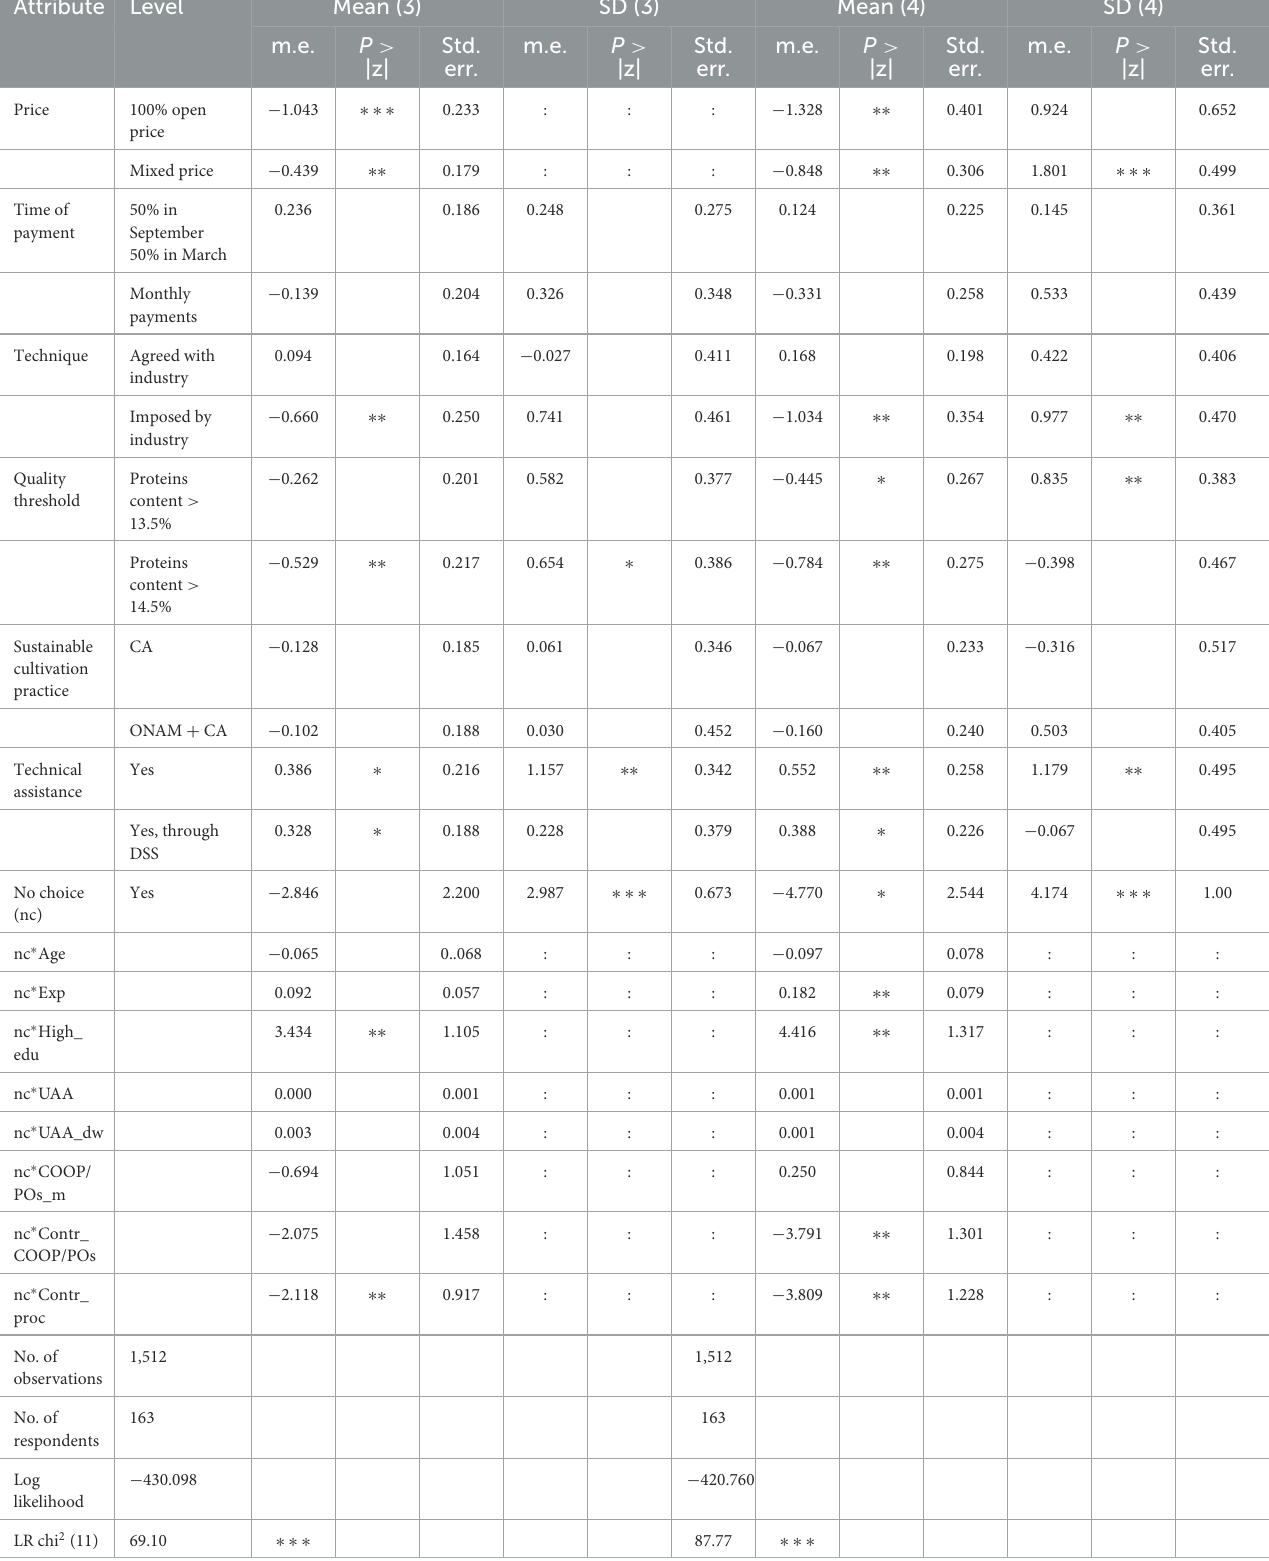
TABLE 5 Parameter estimates for the mixed logit models 3 and 4: marginal effects (m.e.). Attribute